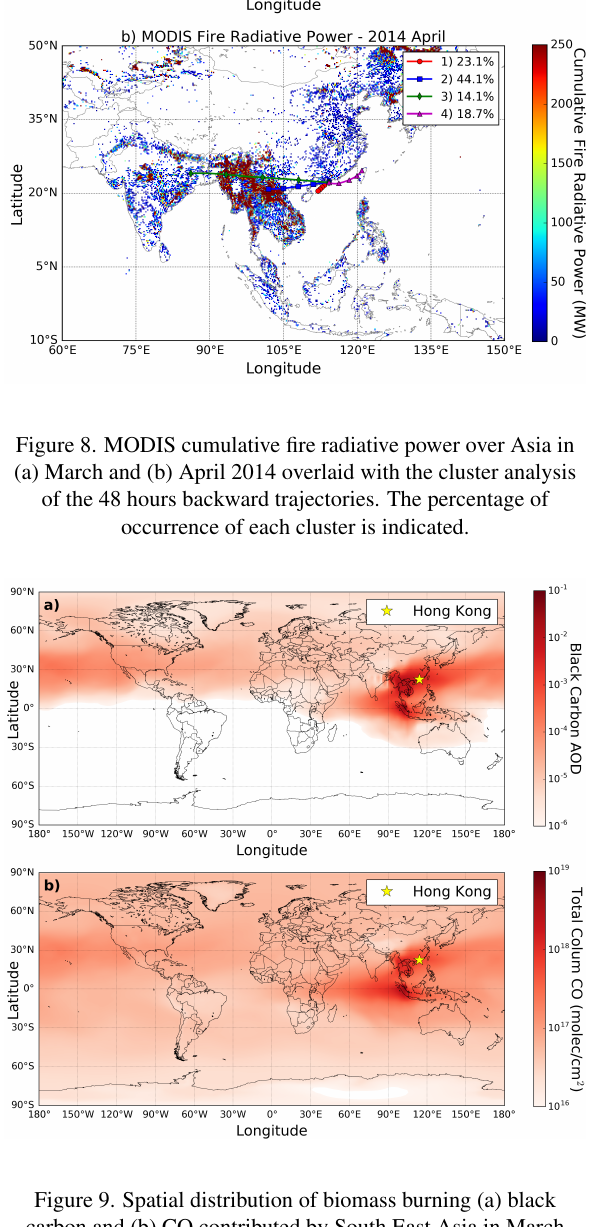
Figure 9. Spatial distribution of biomass burning (a) black carbon and (b) CO contributed by South East Asia in March 2014. The asterisk marker indicates the location of Hong